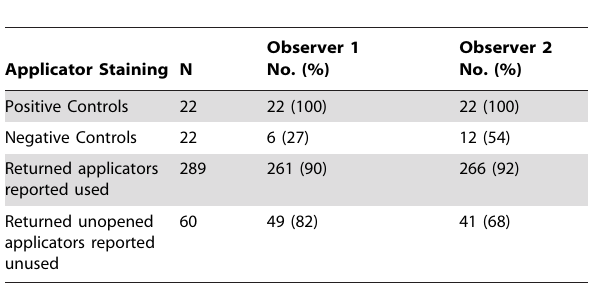
Table 2. Blue Dye staining of polypropylene applicators.